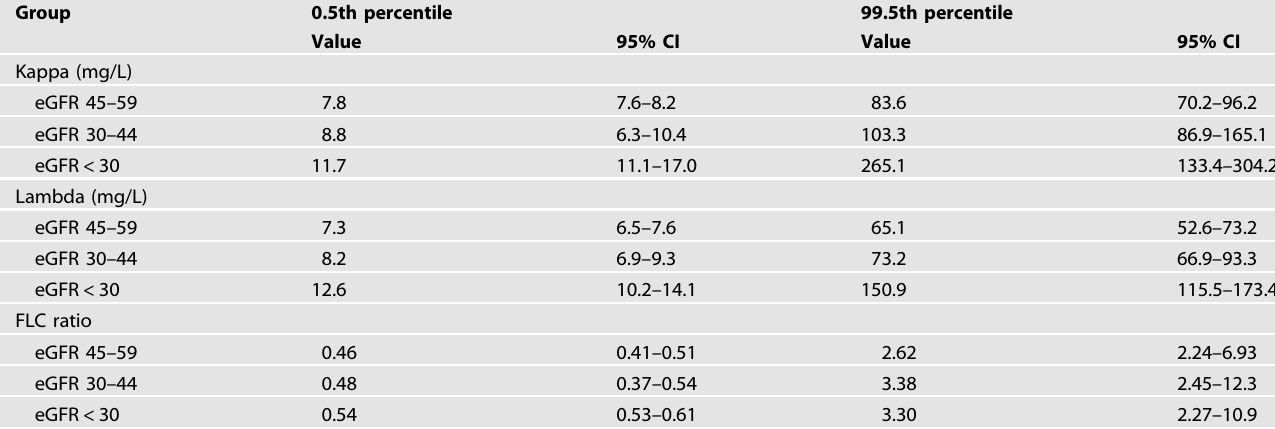
Fig. 3 Comparison of the distribution of kappa and lambda free light chains (FLC) and FLC ratios to current reference intervals by estimated glomerular fi ltration rate (eGFR) subgroups. The portion of the distribution below the 0.5th percentile is shaded red and the portion above the 99.5th percentile is shaded blue. A Serum kappa FLC (green lines 3.3 – 19.4 mg/L). B Serum lambda FLC (green lines 5.7 – 26.3 mg/L). C FLC ratio (green lines – conventional reference interval: 0.26 – 1.65; brown lines – current kidney reference interval: 0.37 – 3.10). Kappa and lambda FLC are truncated at 120 mg/L and FLC ratio at 3.5 in the fi gures for better visualization. eGFR Estimated glomerular fi ltration rate, FLC Free light chains. Table 3. Novel reference intervals for serum kappa FLC (mg/L), serum lambda FLC (mg/L), and FLC ratio in individuals with eGFR of 45 – 59, 30 – 44, and < 30 mL/min/1.73 m 2 .